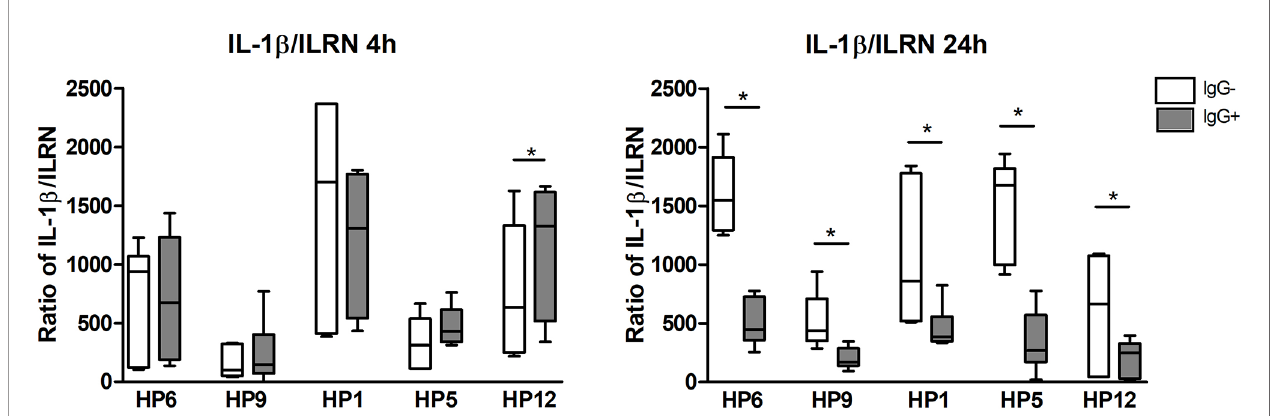
FIGURE 8 | The ratio of mRNA expressions of IL-1 b (pro-in fl ammatory cytokine) and IL-1Ra (the interleukin1-receptor antagonist, anti-in fl ammatory cytokine) at 4 and 24 h PI. Signi fi cant difference between groups with (IgG+) or without (IgG-) the post-vaccinal IgG is denoted by asterisk